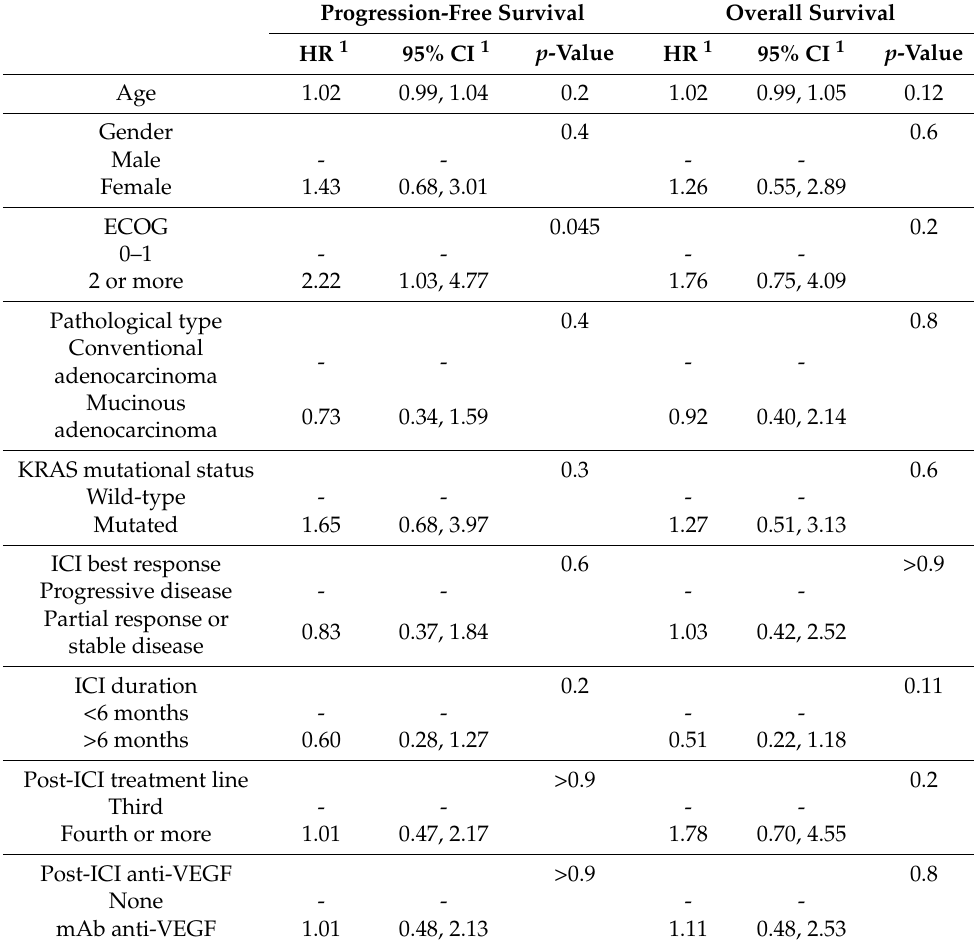
Table 3. Univariate analysis of PFS and OS with post-Immune Checkpoint Inhibitor(s) therapy. Progression-Free Survival Overall Survival HR 1 95% CI 1 p -Value HR 1 95% CI